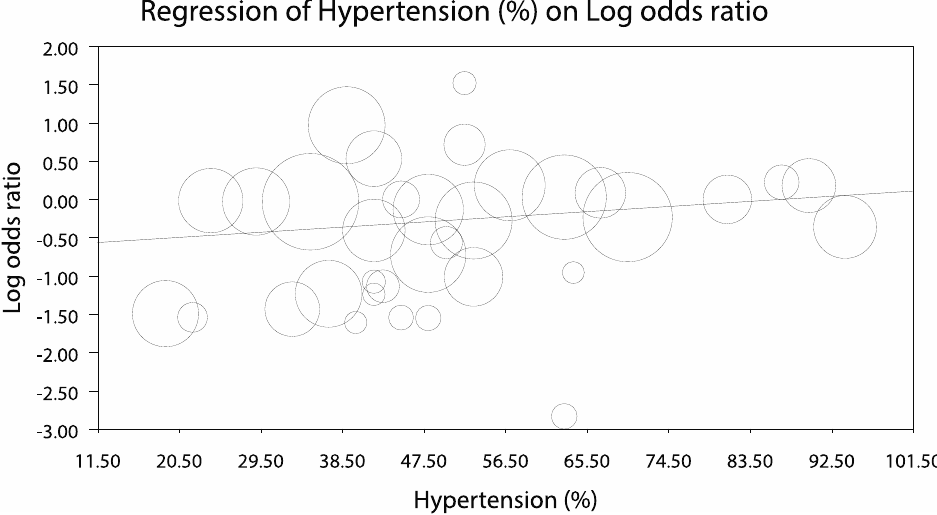
Figure A4. Meta-regression showing the impact of diabetes percentage distribution on Log odds ratio.